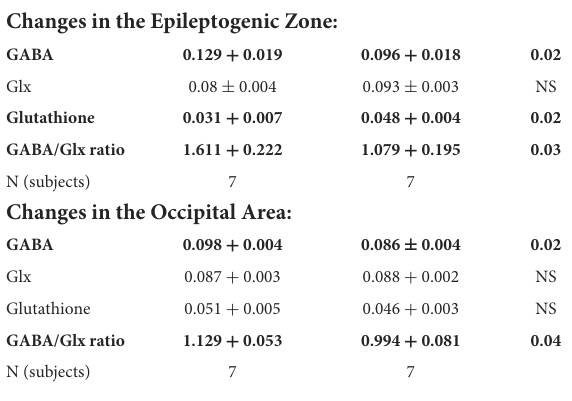
TABLE 2 Effects of transcranial direct current (tDCS) stimulation on brain